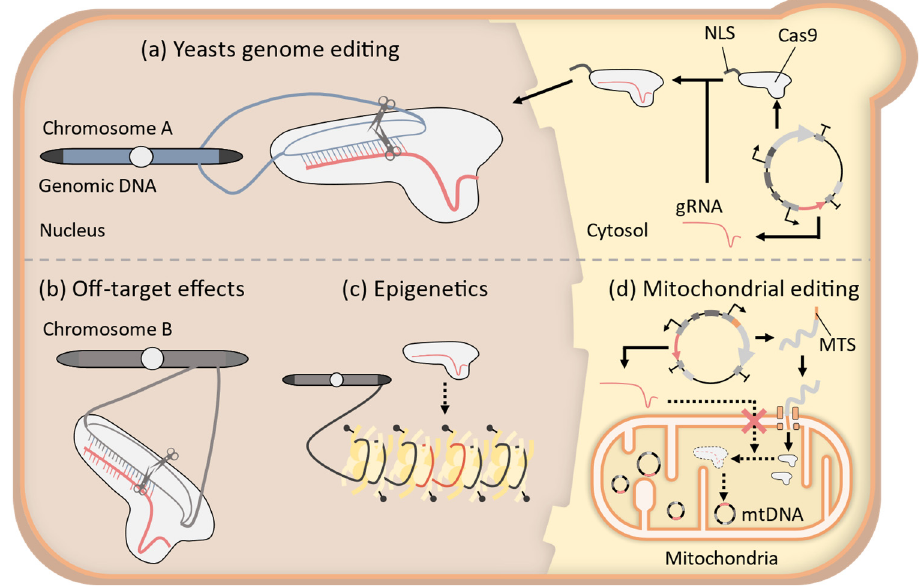
Figure 1. The CRISPR-Cas9 system has several limitations in yeast genome editing. ( a ) Process of common yeast genome editing with CRISPR-Cas9 system. ( b ) gRNA can recruit Cas9 to non-target sequences that are similar to the target sequences. Inducing breaks at these sites causes off-target effects. ( c ) The activity of the Cas9 protein cannot alter the epigenetic state of the target sequence. Moreover, recruitment of the Cas9/gRNA complex can be inhibited by the epigenetic state. ( d ) Cas9 protein can be transported to mitochondria by fusion with a mitochondrial targeting sequence (MTS). However, the transportation mechanism of polynucleotides, such as gRNA, to the mitochondria is currently unclear; therefore, the application of the CRISPR-Cas9 system to mitochondrial DNA (mtDNA) is limited.